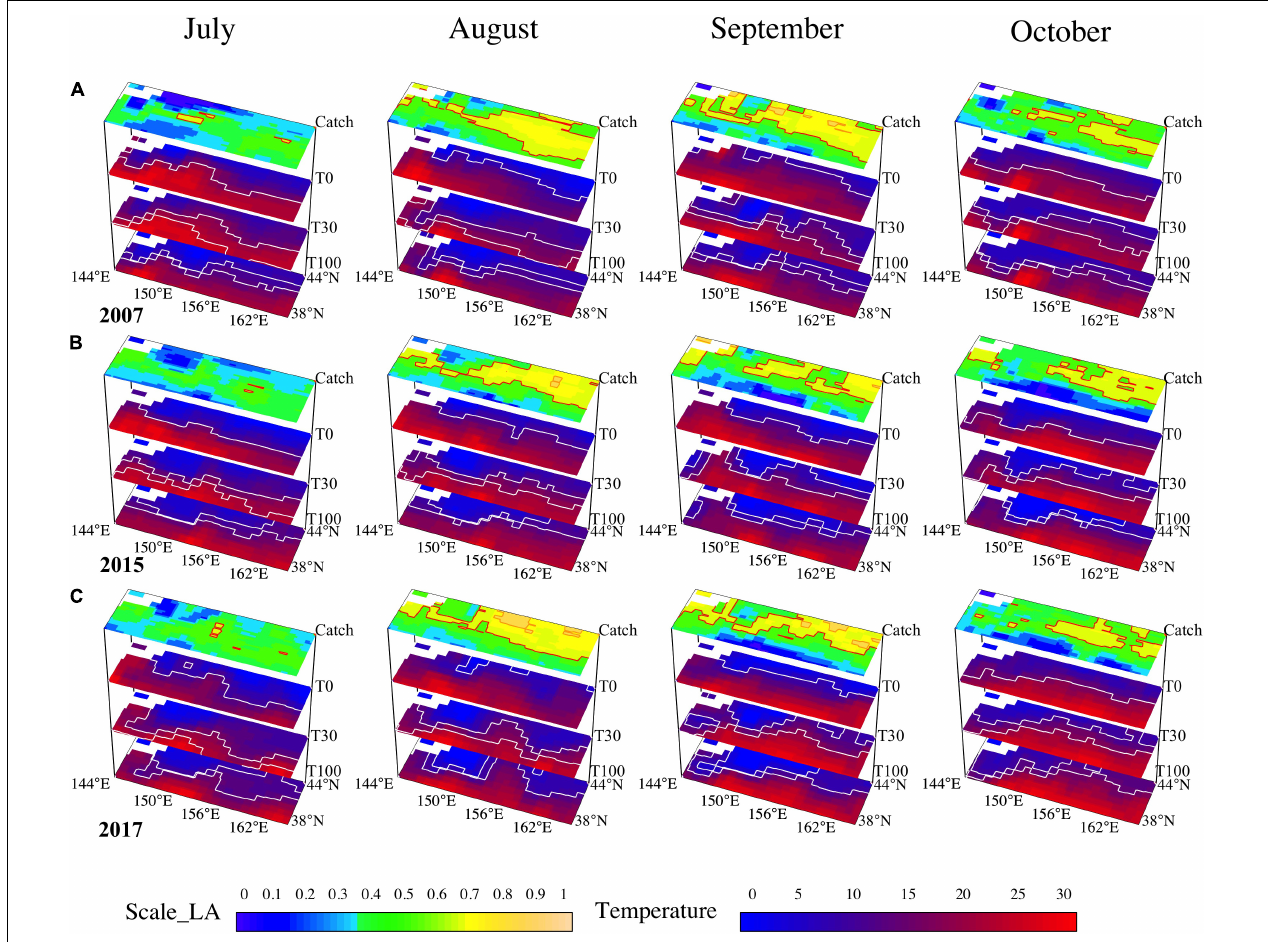
FIGURE 6 | The maps of the habitat area overlapped with the temperature at the surface, 30-m depth, and 100-m depth for the months of July–October in three distinctive years ( A , La Niña year in 2007; B , El Niño year in 2015; C , normal year in